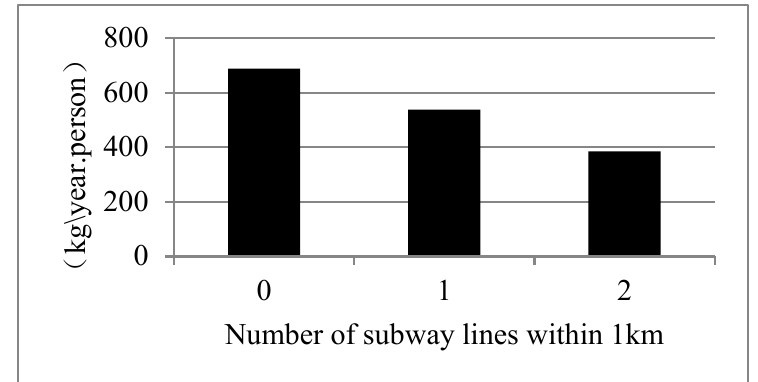
Figure 4. Travel carbon emissions of residents under different subway accessibility.